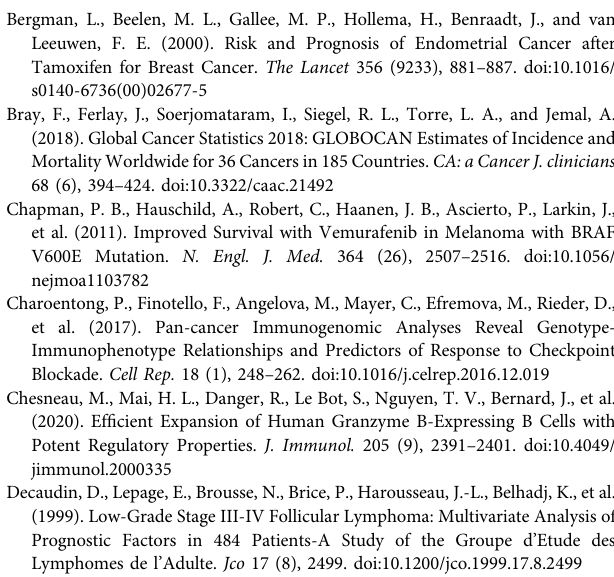
Supplementary Figure 1 | Heatmap of 20 most signi fi cantly upregulated lncRNAs and 20 most signi fi cantly downregulated lncRNAs between GS and GU group. Supplementary Figure 2 | Relationship between the expressions of fi ve genetic instability-related lncRNAs and clinicopathological features. SupplementaryFigure3| Functionalenrichmentoftranscriptmessageofgenomic instability-related lncRNAs in the high- and low-risk groups. Supplementary Figure 4 | Strati fi ed analyses of clinicopathological factors in EC between the high-risk and low-risk groups: (A,B) age, (C,D) grade, and (E,F) histological type. Supplementary Figure 5 | Correlation between the expression of fi ve prognostic lncRNAs and tumor-in fi ltrating immune cells (TICs). Supplementary Figure 6 | Distribution of variants based on variant classi fi cation, type, and SNV class. Bottom part (from left to right) indicates mutation load for each sample and the top 10 mutated genes in patients with endometrial cancer (A,B) . Supplementary Figure 7 | Prediction of response to common chemo-drugs between the high-risk and low-risk groups based on GDSC database. IC 50 , half- maximal inhibitory concentration. Supplementary Figure 8 | Expression level of PIK3CD-AS2, AC129507.4, GLIS3.AS1, LINC01224, and AC007389.3 in clinical